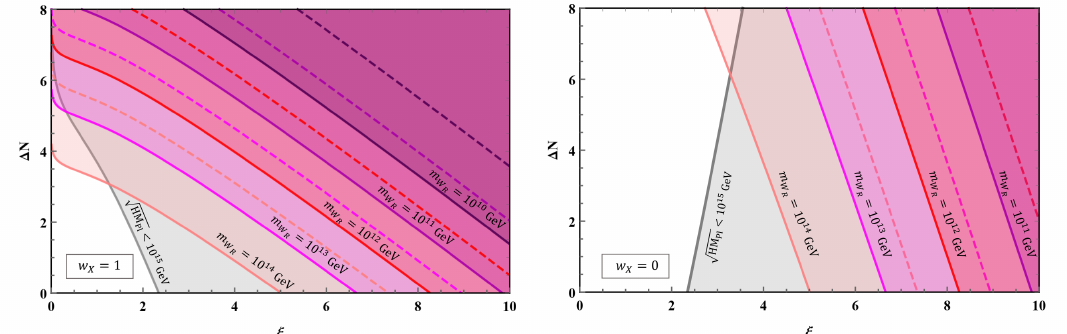
for w = 1 (Left Panel) X R √ HM < 10 15 GeV . Pl